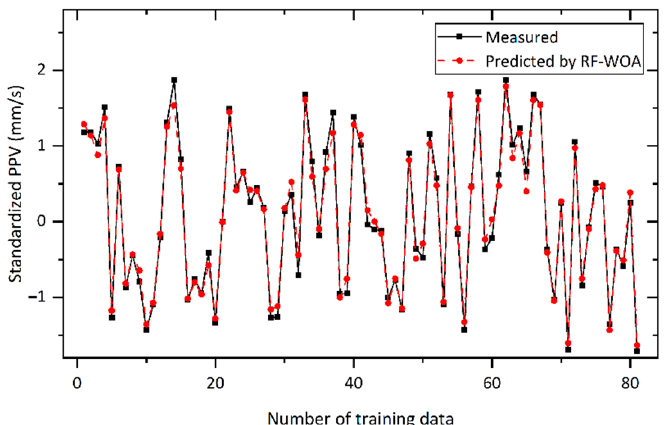
Figure 12. Measured and predicted PPV of the RF-WOA model on the training set.